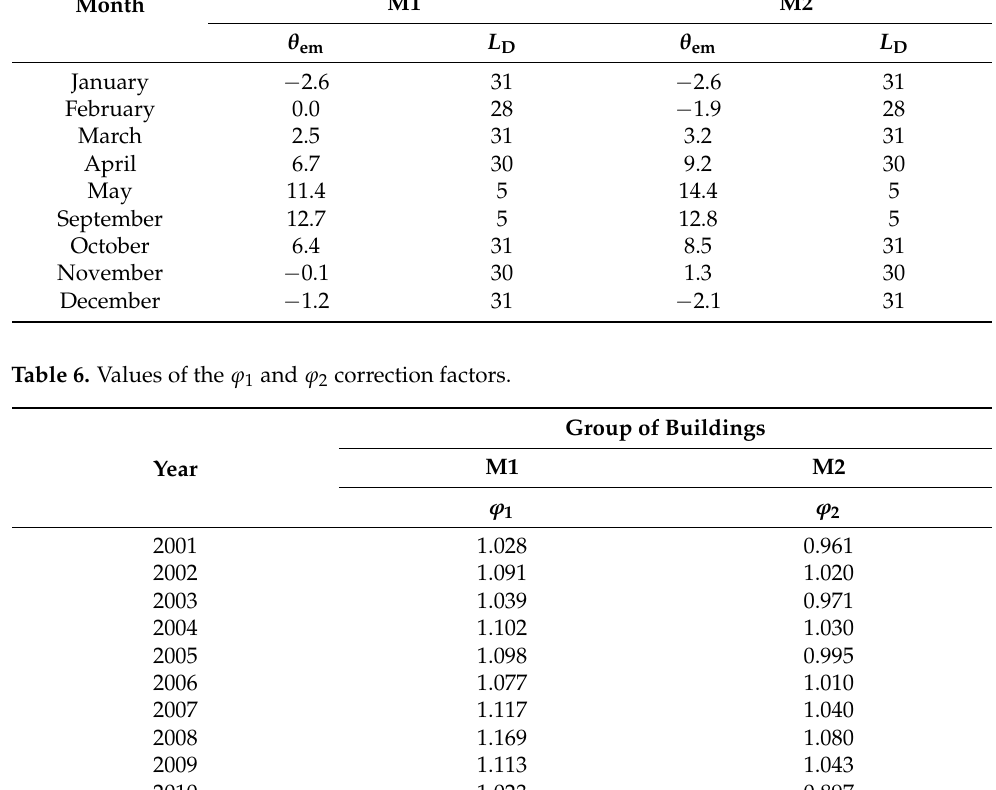
Table 5. Climatic data for the analyzed meteorological stations [38,39]. Month